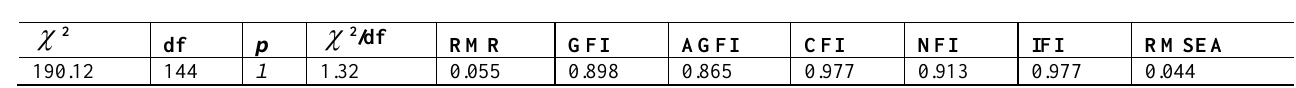
Table 6: Goodness-of-fit indices